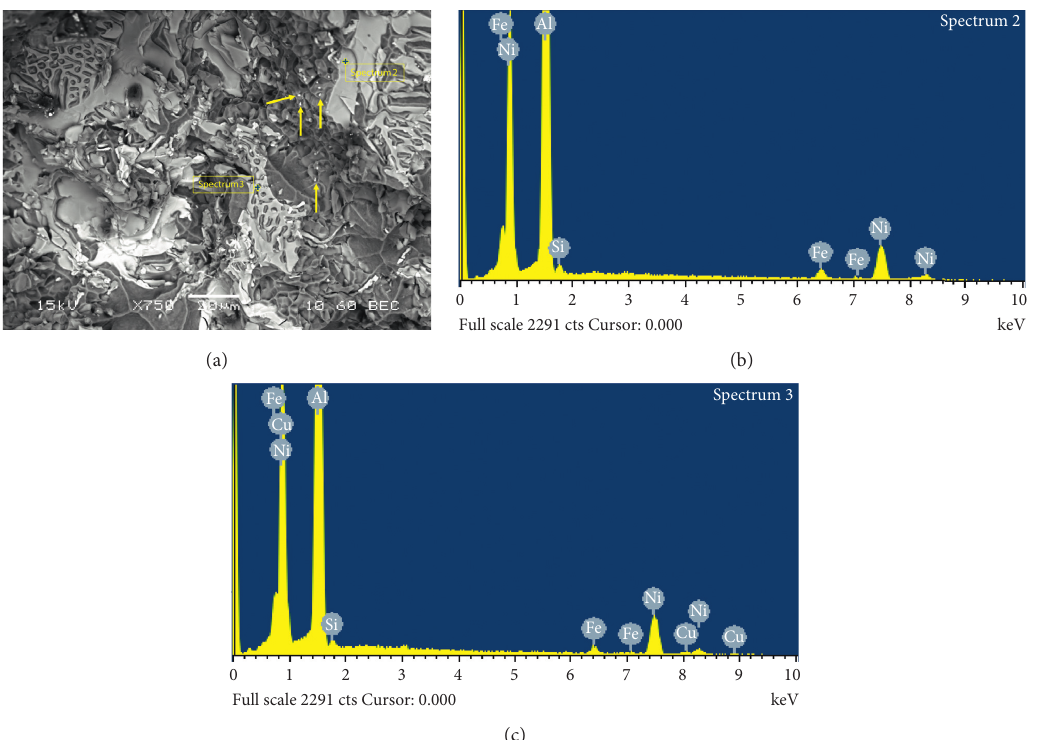
Figure 8: (a) BSE image of T6-treated M2S alloy after stabilization at 250 ° C for 200 hours showing the dimple structure, coarsened precipitates, and phases involved in the crack initiation process and (b), (c) EDS spectra identifying the Ni-rich phases shown in